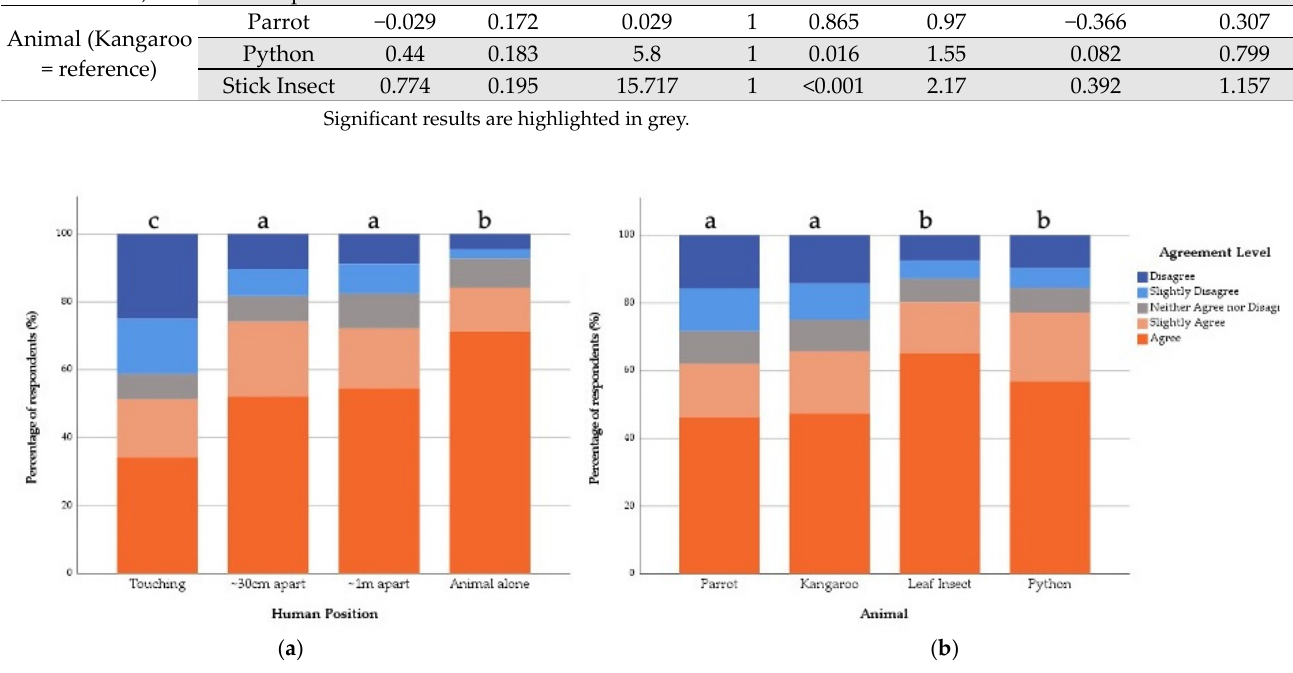
Figure 4. Percentage of Zoo Community respondents’ agreement with the statement “the featured animal is displaying a natural behaviour” in relation to the ( a ) Human Position shown and ( b ) Featured Animal shown. Same letters indicate no statistical difference and different letters indicate statistical differences between variables in the fitted model.